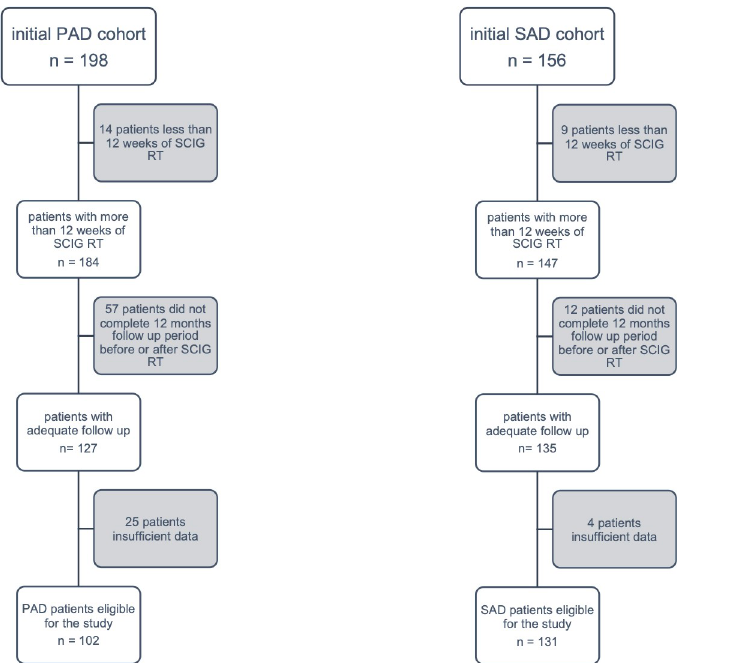
Fig 1. Inclusion criteria in PAD and SAD